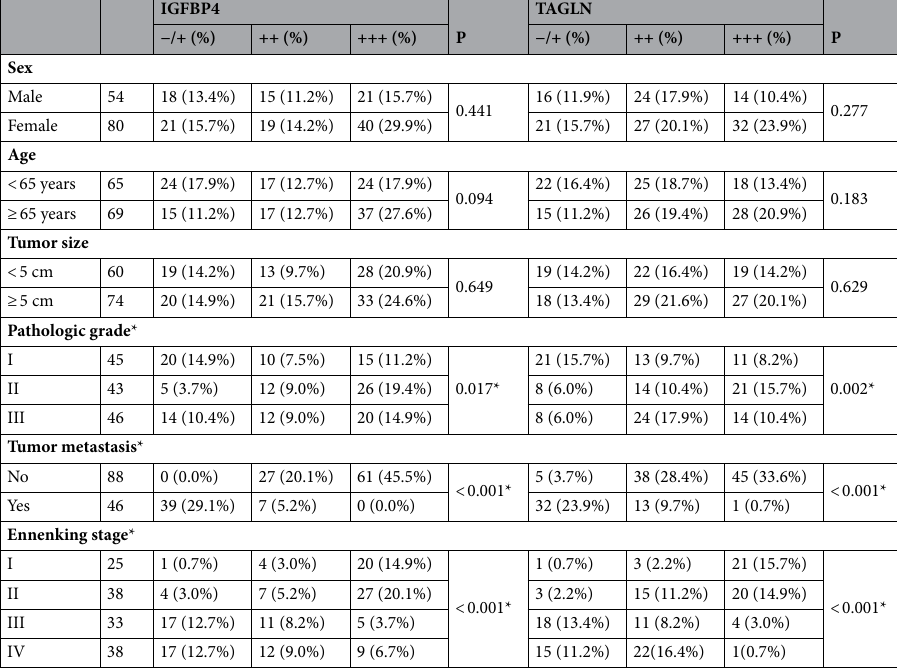
Table 1. Clinicopathological variables and the expression status of IGFBP4 and TAGLN. Pearson’s Chi- squared test was used. *P < 0.05.